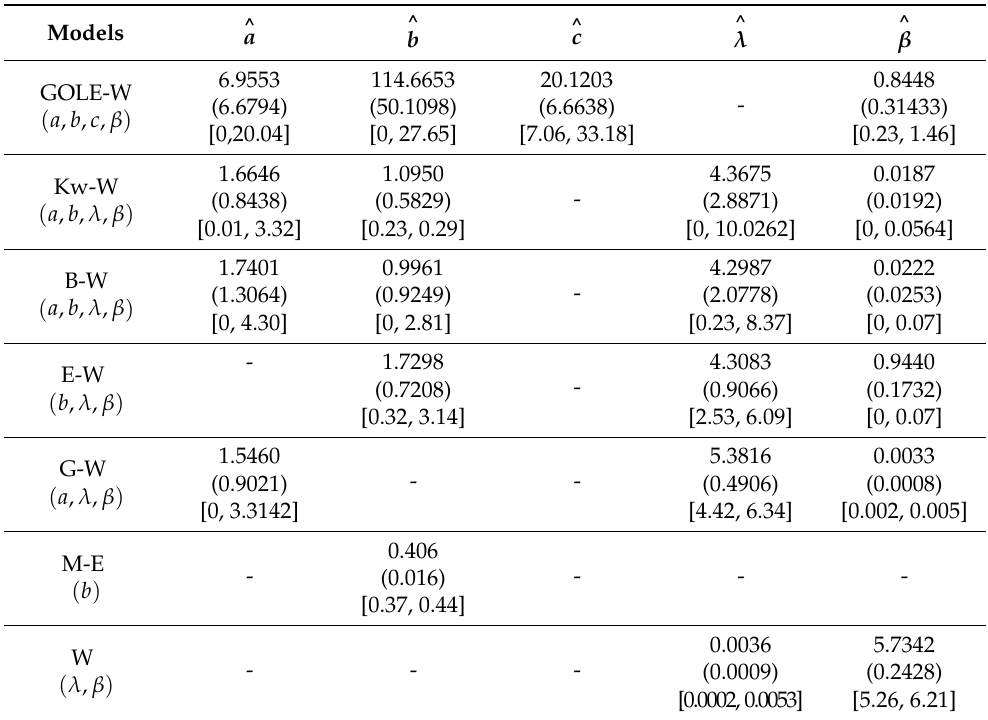
Table 9. MLEs, standard errors (in parentheses), confidence interval values [in brackets] for data set II.